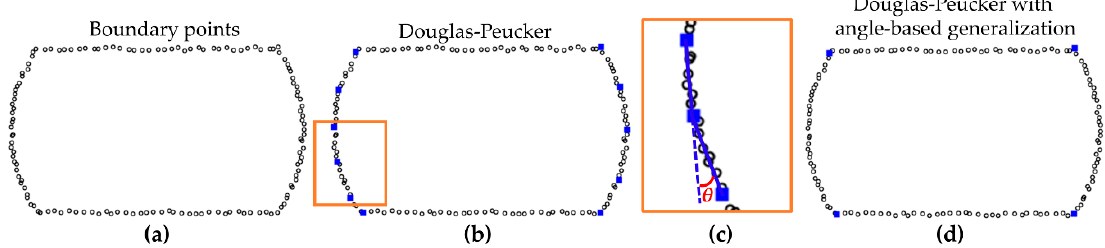
Figure 4. Determination of critical points. Boundary points ( a ), and critical points derived from Douglas–Peucker (blue squares) ( b ) and from angle-based generalization (blue squares ( d ). Angle θ between two adjacent lines formed by connecting adjacent critical points ( c ).